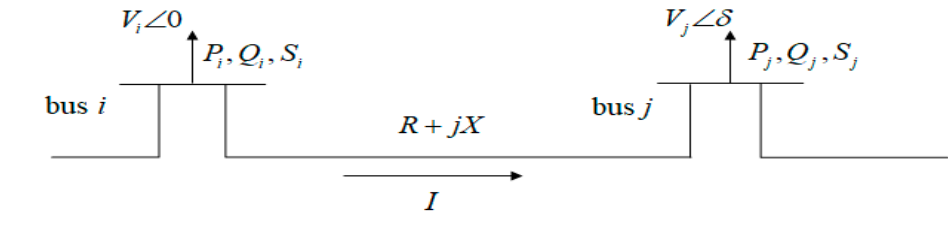
Figure 2. Two-bus model representation .